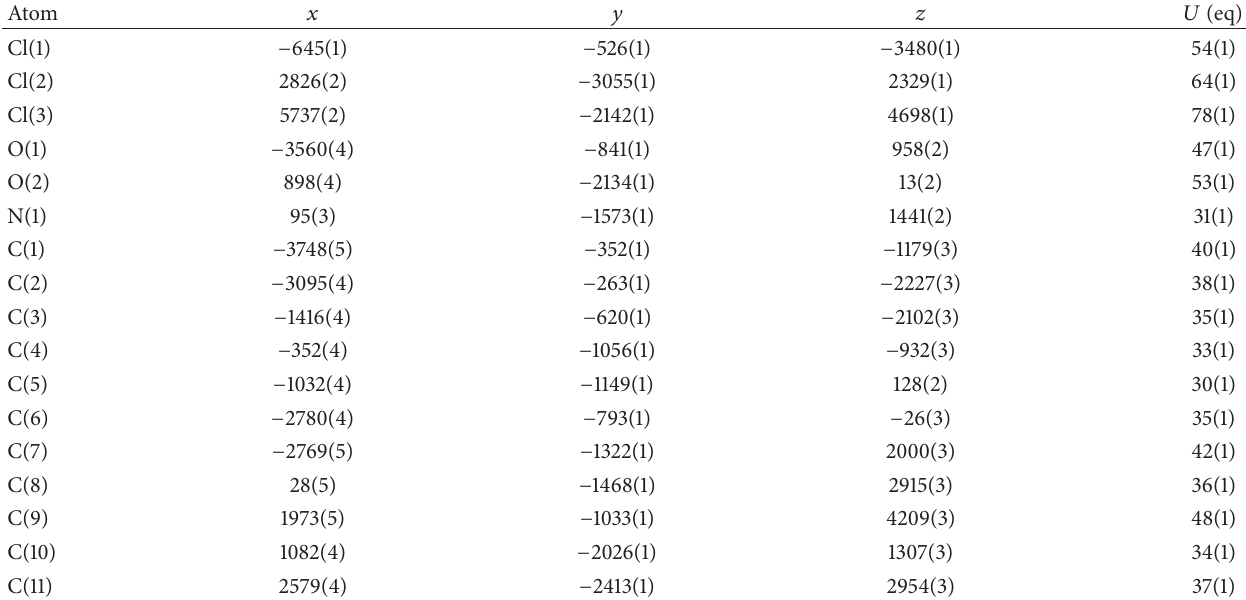
Table 3: Atomic coordinates ( × 10 4 ) and equivalent isotropic displacement parameter ( × 10 3 ) for nonhydrogen